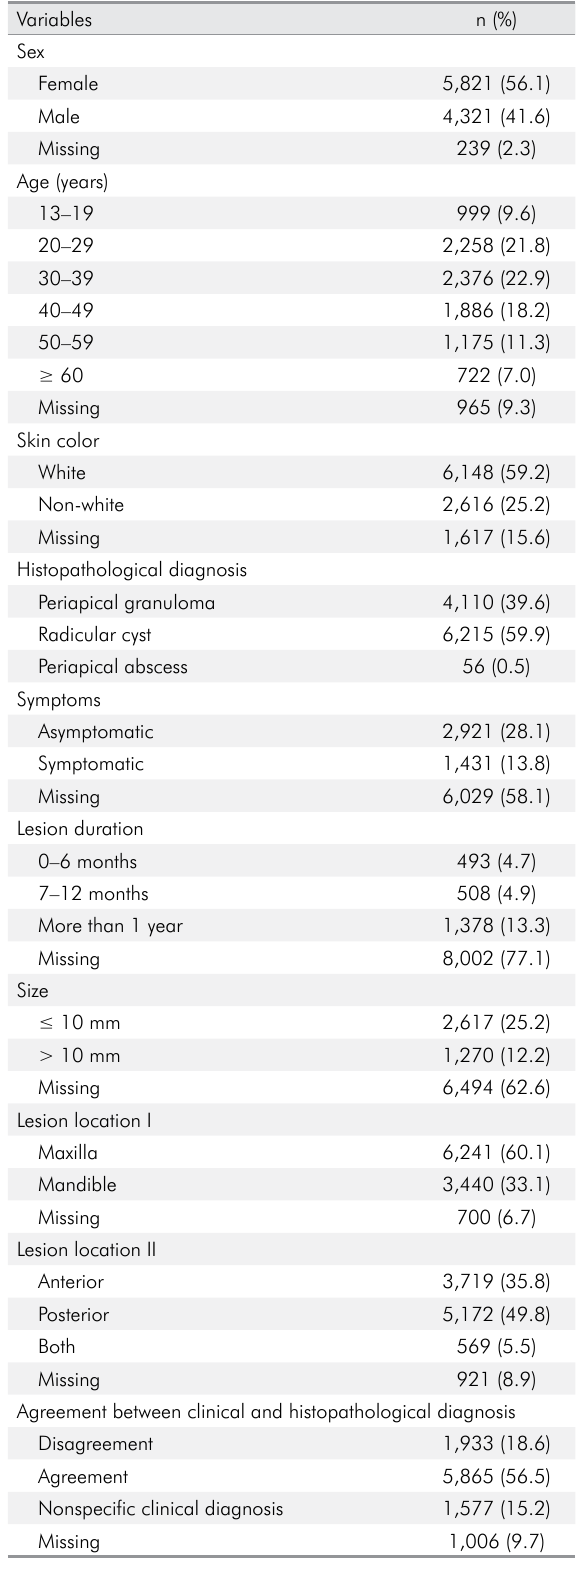
Table 2. Distribution of the clinical and demographic features of 10,381 cases of chronic inflammatory periapical